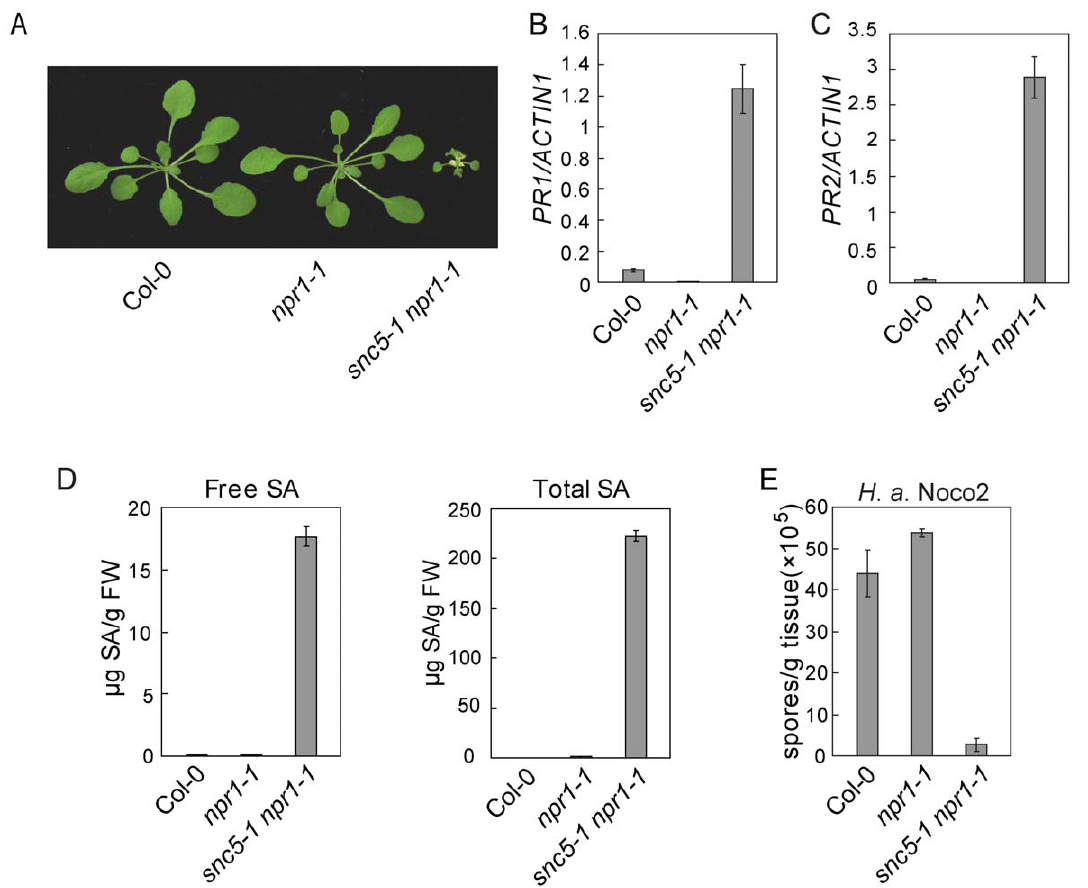
Figure 1. Defense responses are constitutively activated in snc5-1npr1-1 . (A) Morphology of wild type (Col-0), npr1-1 and snc5-1 npr1-1 plants grown on soil. The picture was taken when the plants were four weeks old. (B–C) Expression levels of PR1 (B) and PR2 (C) in wild type, npr1-1 and snc5-1 npr1-1 compared to Actin 1 . Error bars represent standard deviation from three measurements. (D) Free and total SA levels in wild type (Col-0), npr1-1 and snc5-1 npr1-1 . Error bars represent standard deviation from four measurements. (E) Growth of H. a. Noco2 on wild type (Col-0), npr1-1 and snc5-1 npr1-1 . Error bars represent standard deviation from three measurements.